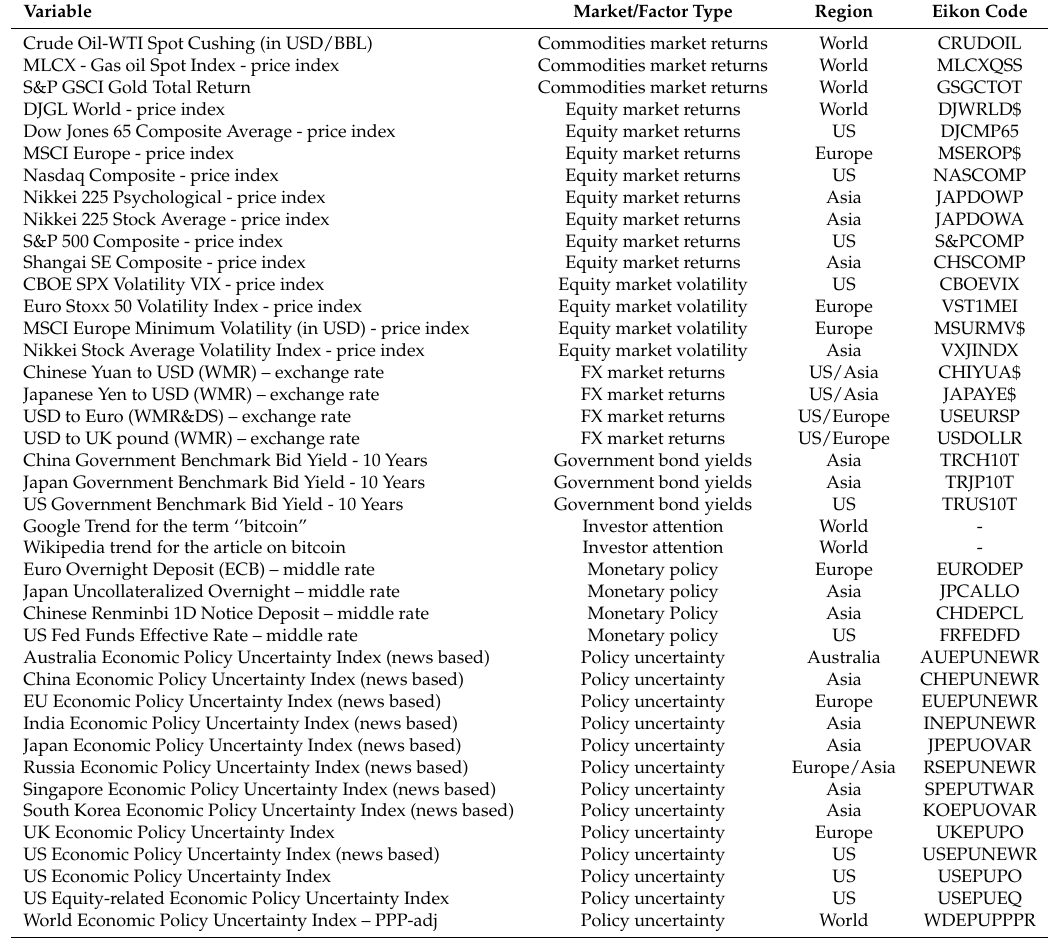
Table A1. Variables employed, sample: June 21st 2010 to May 31st 2018 (7-day week; 2872